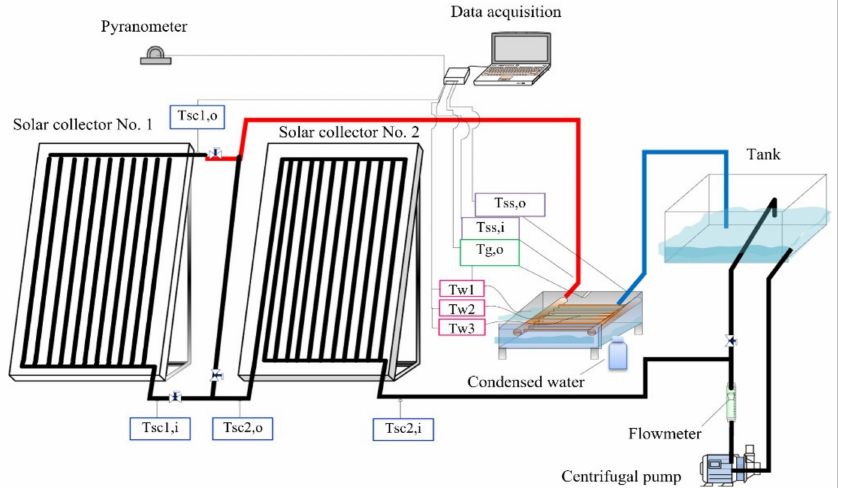
Figure 7. Schematic diagram of the effect of varying heat transfer coefficient of heat exchanger- equipped solar still by nanofluids